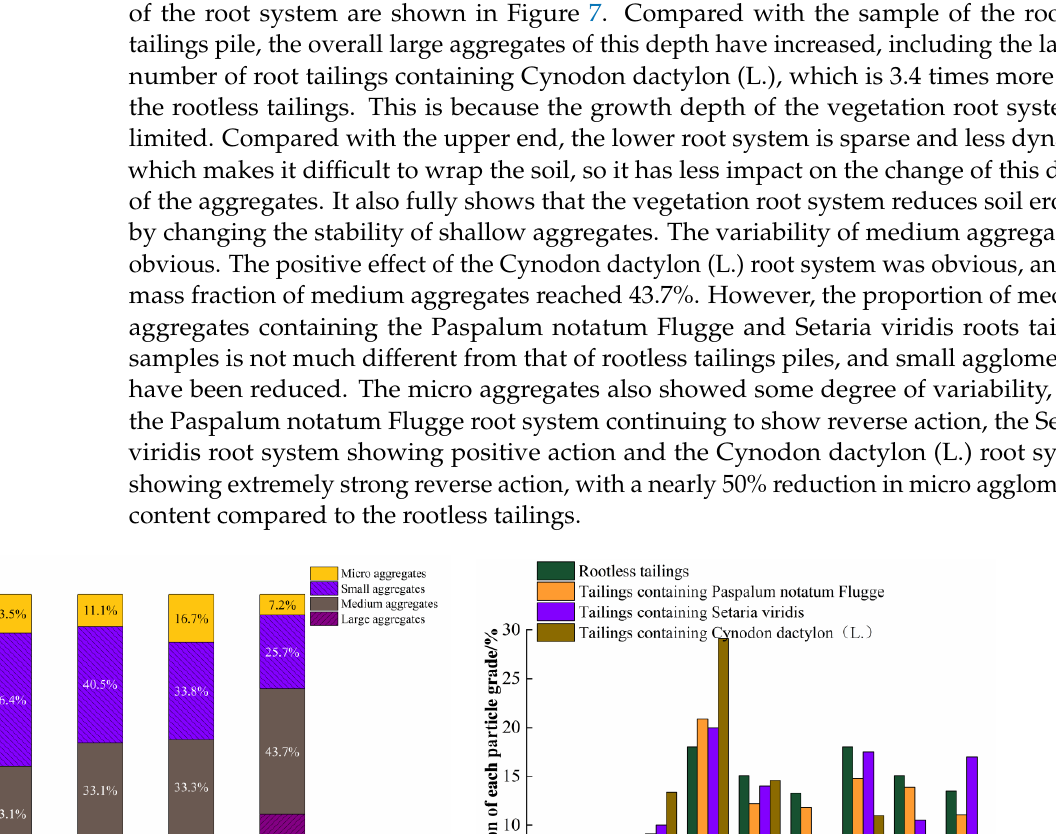
Figure 6. Distribution characteristics of aggregates. ( a ) Effect of the root system on aggregates’ content; ( b ) particle size distribution of aggregates.